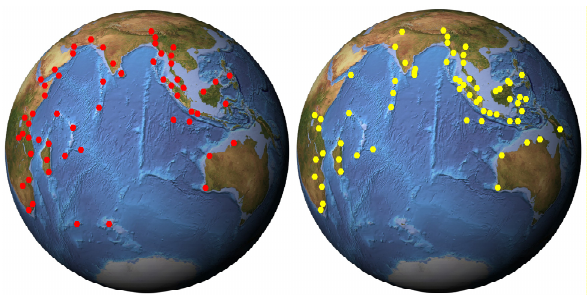
Figure 2: Recommendation of Working Group 2 for the establishment of an Indian Ocean wide tide gauge network. Left: Plan developed min 2005. Right: Status of the network in 2009 (the blue marked tide gauges for 2009-2010 are in operation now).